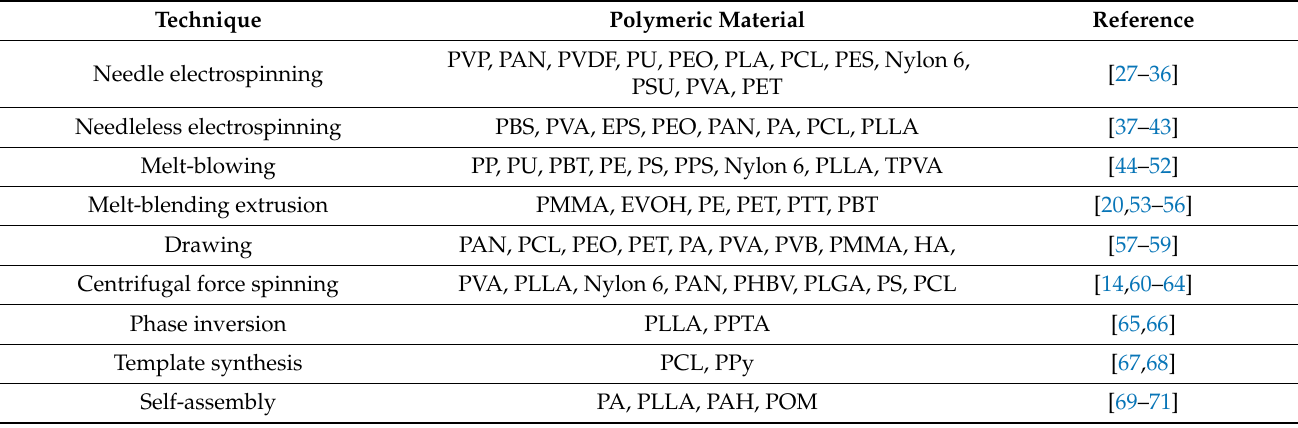
Figure 1. Various types of nanofiber production techniques. ( a ) Needle electrospinning, reproduced with permission from [21], copyright 2021 Springer Nature; ( b ) needleless electrospinning, reproduced with permission from [22], copyright 2021 Elsevier; ( c ) melt-blowing, reproduced with permission from [23], copyright 2013 Elsevier; ( d ) melt-blending, reproduced with [24], ( e ) drawing, reproduced with permission from [25], copyright 2014 Taylor & Francis; ( f ) centrifugal force spinning, reproduced with permission from [26], copyright 2018 Springer Nature; ( g ) phase separation, reproduced with permission from [25], copyright 2014 Taylor & Francis; ( h ) template synthesis, reproduced with permission from [25], copyright 2014 Taylor & Francis; and ( i ) self-assembly, reproduced with permission from [25], copyright 2014 Taylor & Francis. Table 1. Types of polymeric materials used in different nanofiber production